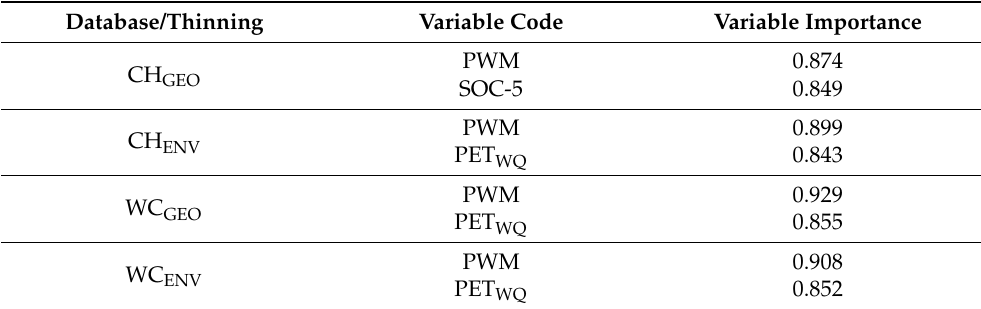
precipitation of wettest month; PET WQ : mean monthly potential evapotraspiration of wettest quarter; SOC-5: predicted mean value of soil organic carbon mass fraction at standard depth of 5